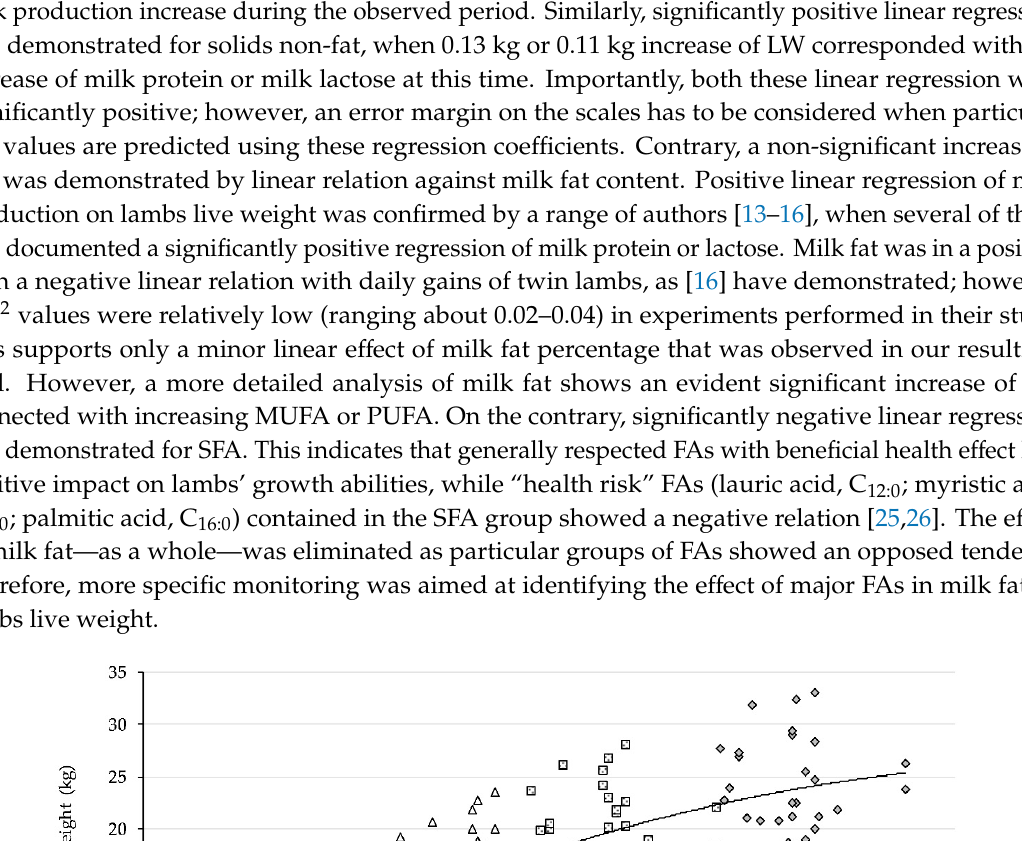
Animals 2019 , 9 , x Figure 1. Growth curve (third order polynomial function) estimated for Wallachian lambs. 1 st day of lambs live weight monitoring; 2 nd day of lambs live weight monitoring; 3 rd day of lambs live weight monitoring; 4 th day of lambs live weight monitoring.